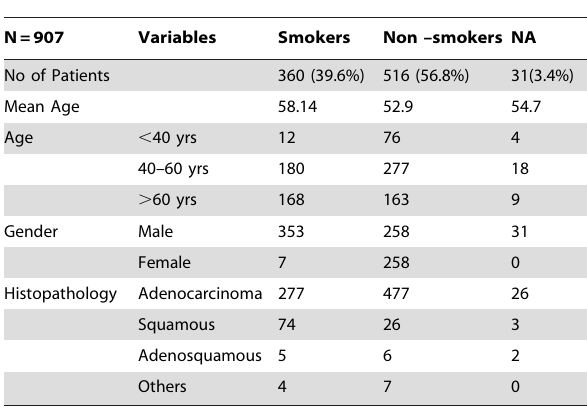
Table 2. Patient Demographics.